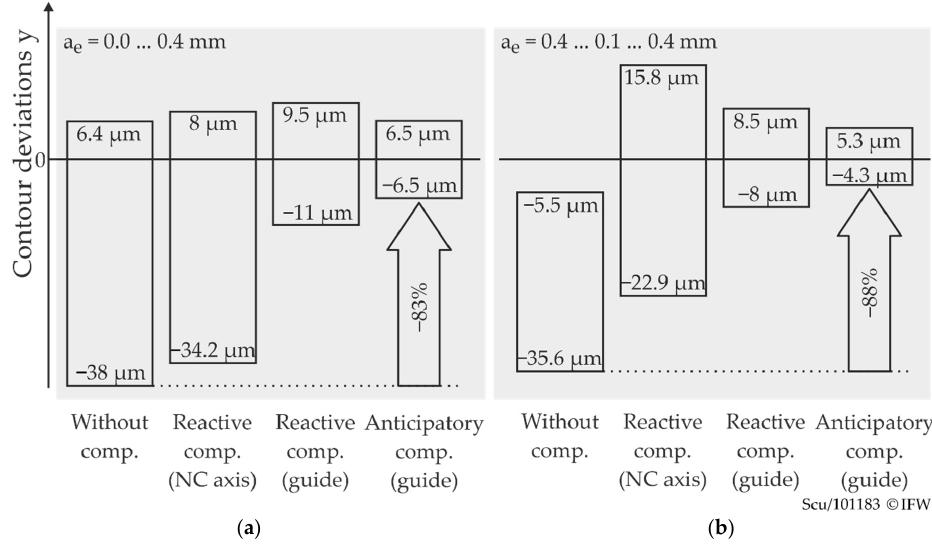
Figure 12. Summarised results of the milling experiments: ( a ) transition from ae = 0 to 0.4 mm; ( b ) transition from a e = 0.1 mm to 0.4 mm.